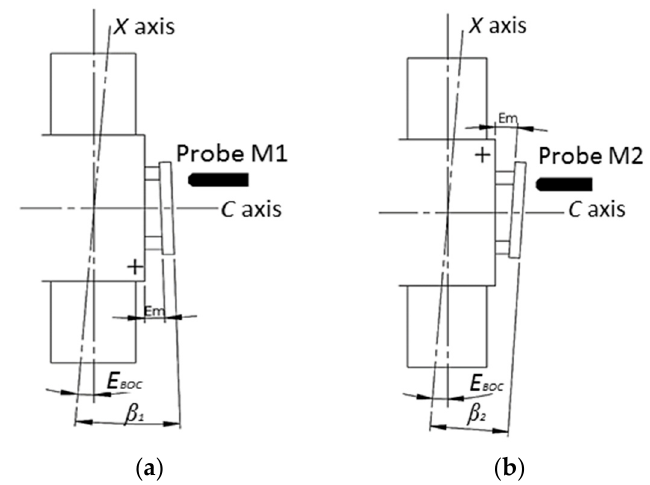
Figure 12. Schematic diagram of E BOC measurement. ( a ) Before reversal operation, ( b ) After reversal operation.